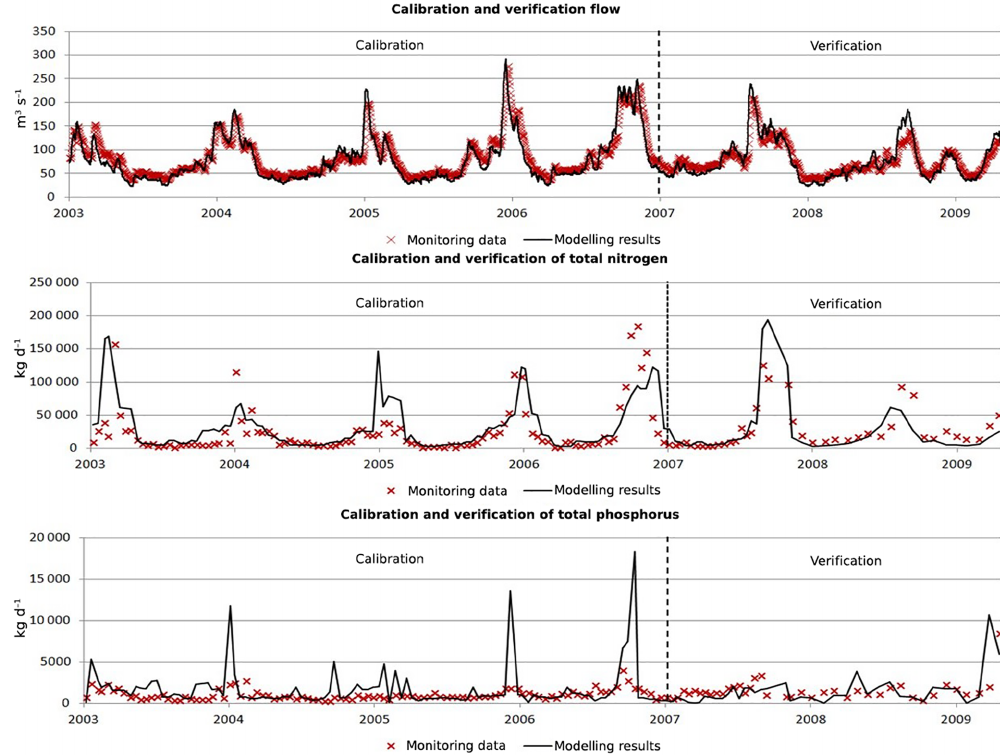
Figure 6. Matching of modelling results and monitoring results for the period of calibration and verification.